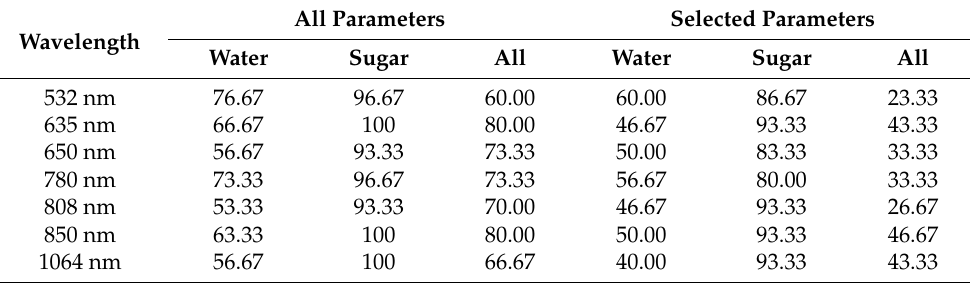
Table 6. Classification results (%) of LDA on wine adulteration based on laser backscattering. All Parameters Selected Wavelength